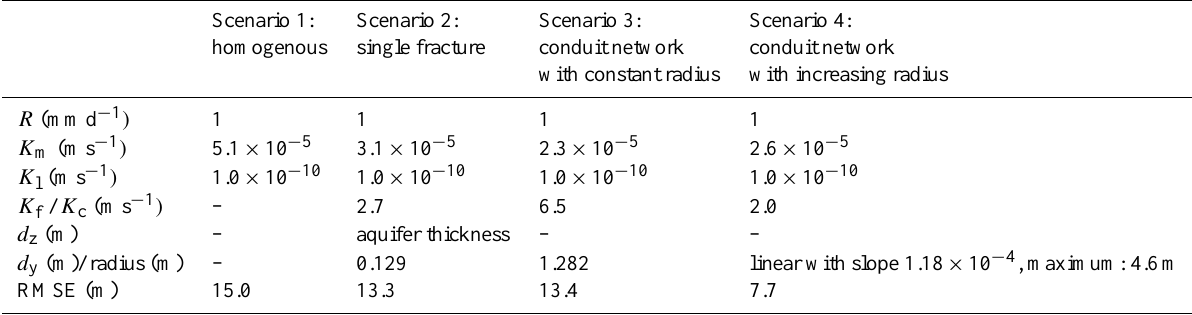
Table 1. Input and calibration values of the different scenarios. The root mean square error of the hydraulic head distribution is given as an index for the quality of the model